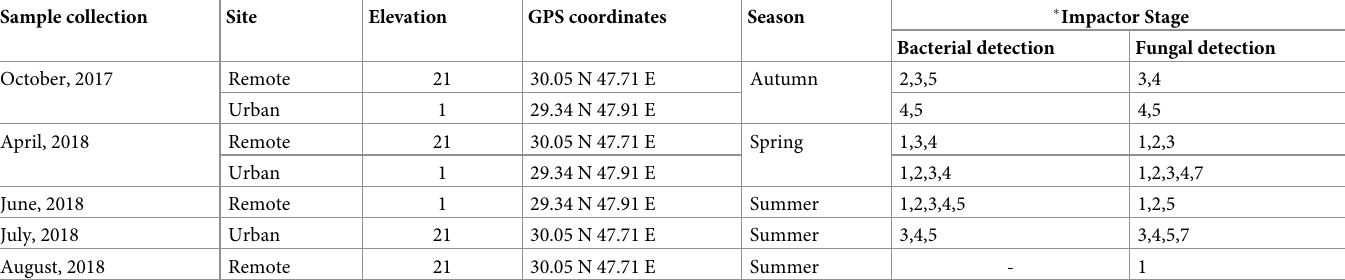
� Numbers 1–7 represent the stage of the impactor. Dust fractions impacted on stage 1–5 fall under the respirable category, whereas stage 7 represents the inhalable portion of the air-borne dust. Sampling was done for a period of 48 hours. The total suspended PM in each size fraction were between the aerodynamic diameter (Dp) sizes ranges of < 0.39 (backup high volume filter-stage 7), 0.39 to 0.69 (stage 6), 0.69 to 1.3 (stage 5), 1.3 to 2.1 (stage 4), 2.1 to 4.2 (stage 3), 4.2 to 10.2 (stage 2) and > 10.2 μ m (stage